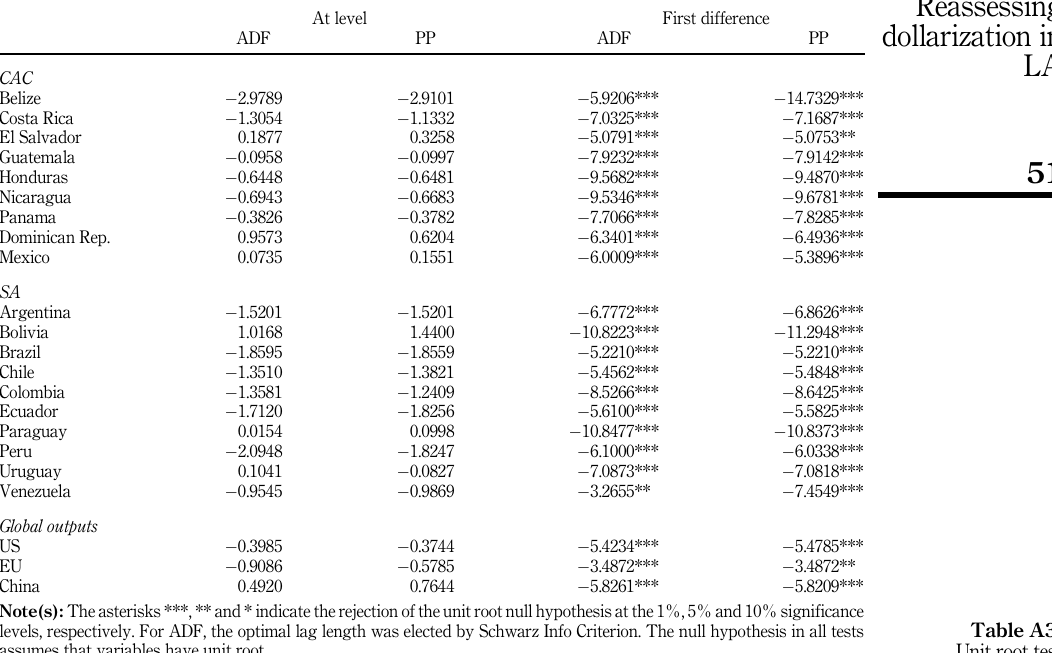
Table A3. Unit root test